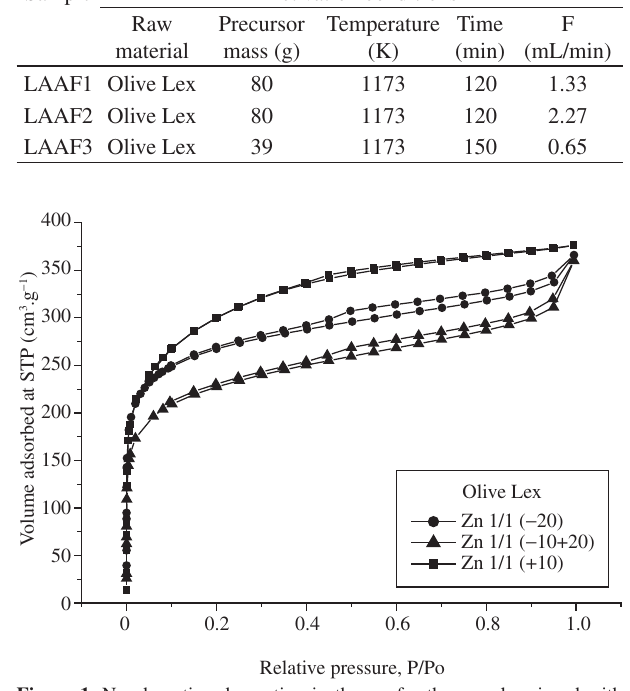
Figure 1. N adsorption-desorption isotherms for the samples sieved with 2 different mesh